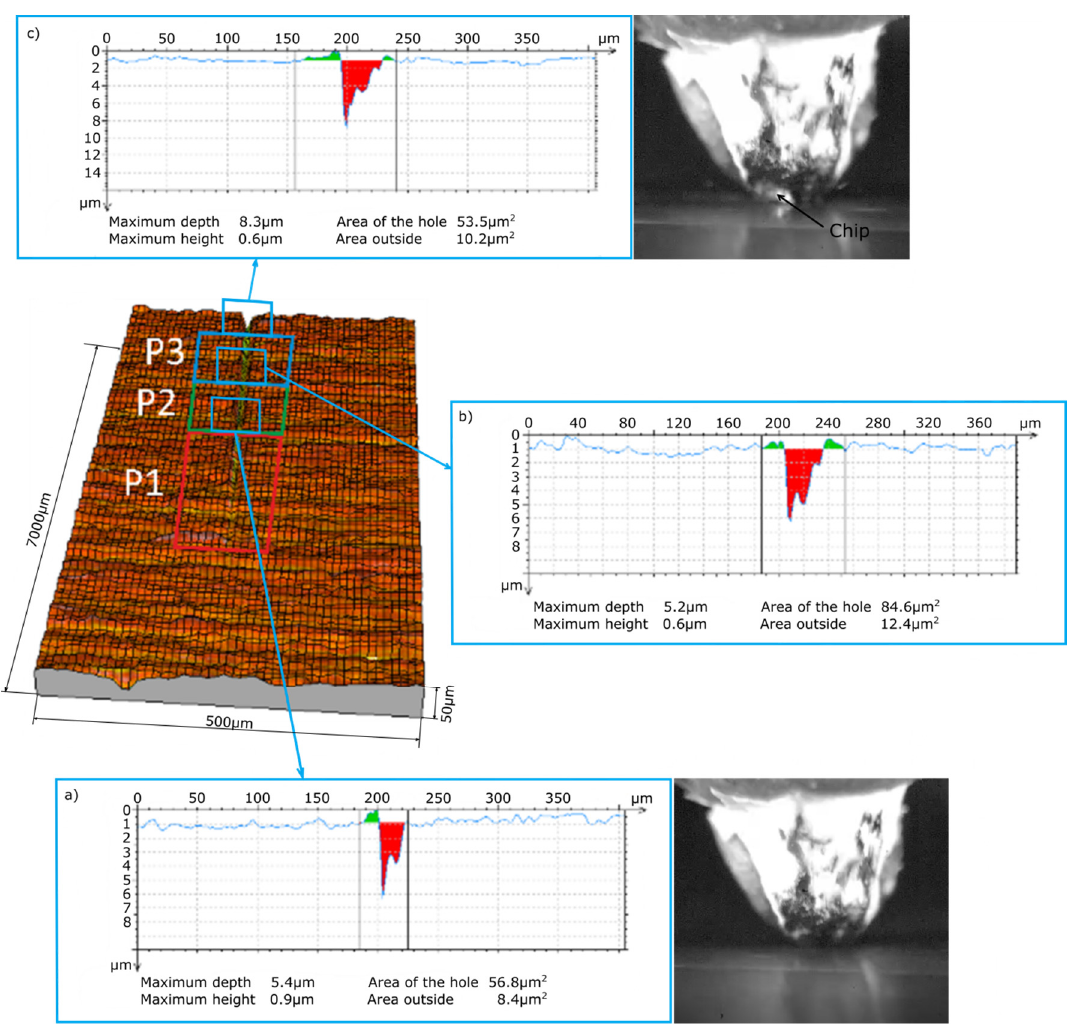
Figure 6. View of the initial stage of the scratch formed by the ZS2 abrasive grain and cross-sections of the scratch at the end of the stages: ( a ) P1, ( b ) P2 and ( c ) P3.